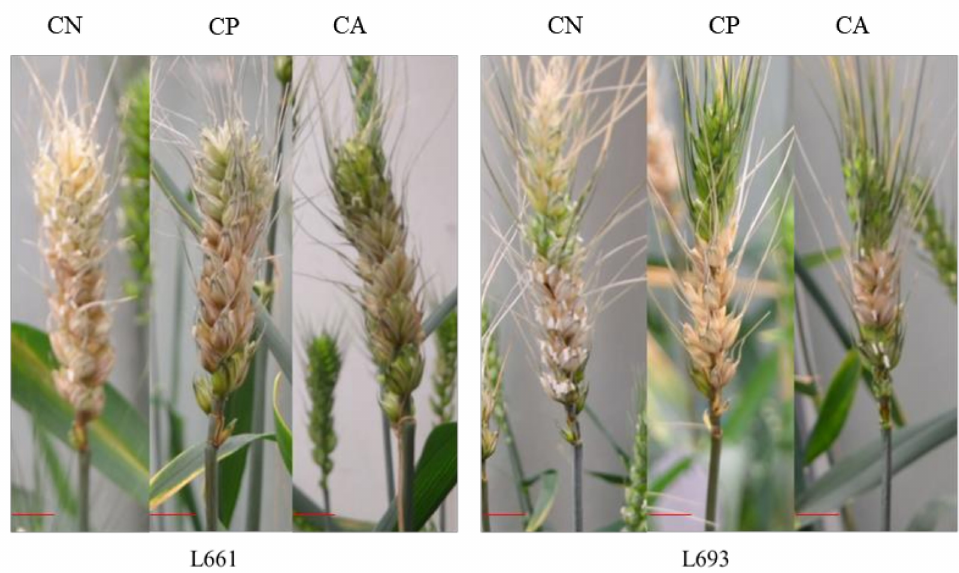
Figure 1. Fusarium head blight symptoms at 14 DAI in greenhouse for L661 and L693. CN, CP, and CA − cutting no leaf, cutting some leaves (flag leaf remains), and cutting all leaves, respectively. Scale bar, 1.0 cm.